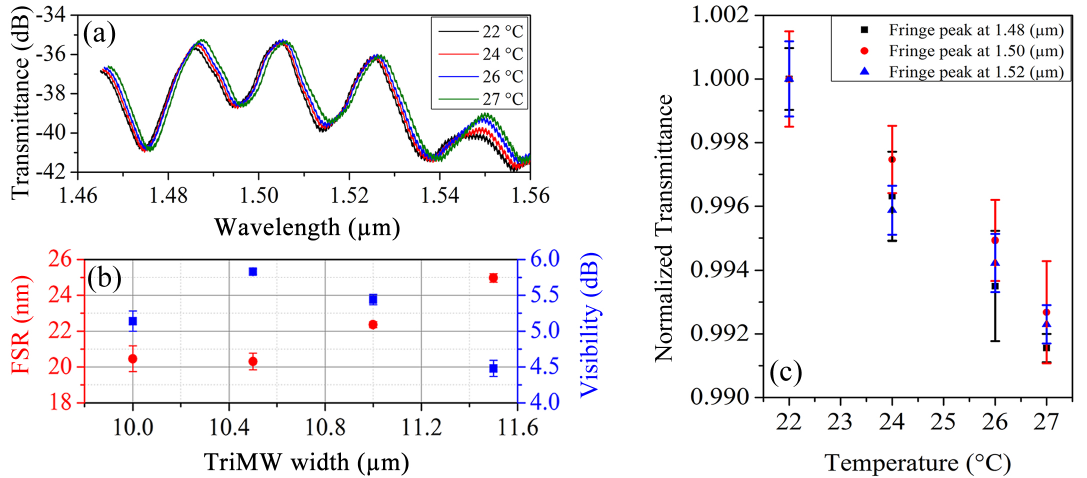
Figure 4. Sensitivity measurement in trimodal devices. ( a ) Measured interferometric signal resulting from the modal interaction within a trimodal interferometer with 3.5µm width in the single mode section and 10.5µm width in the multimodal region. ( b ) FSR and visibility analysis for a trimodal interferometric device with 600nm height and cross-section with single mode section width of 3.5µm and variable multimode section width between 10µm and 12µm, with a 0.5µm pitch. ( c ) Normalized transmittance as function of temperature variation for fringe peaks at 1485nm, 1505nm and